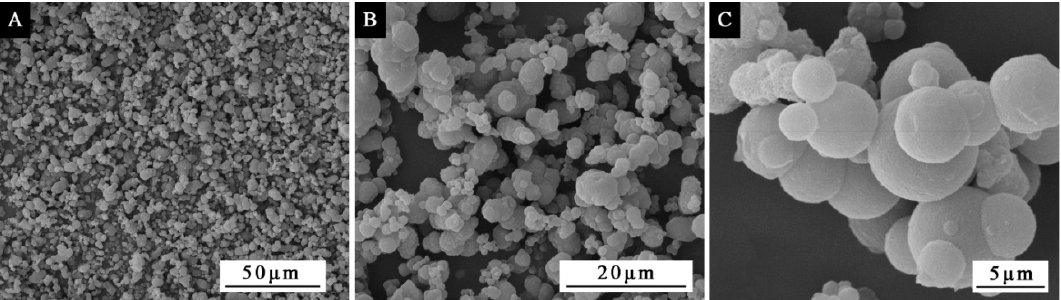
Figure 6. The SEM morphology of microcapsule prepared under two months of deposition: ( A ) low magnification, ( B ) medium magnification, ( C ) high magnification.